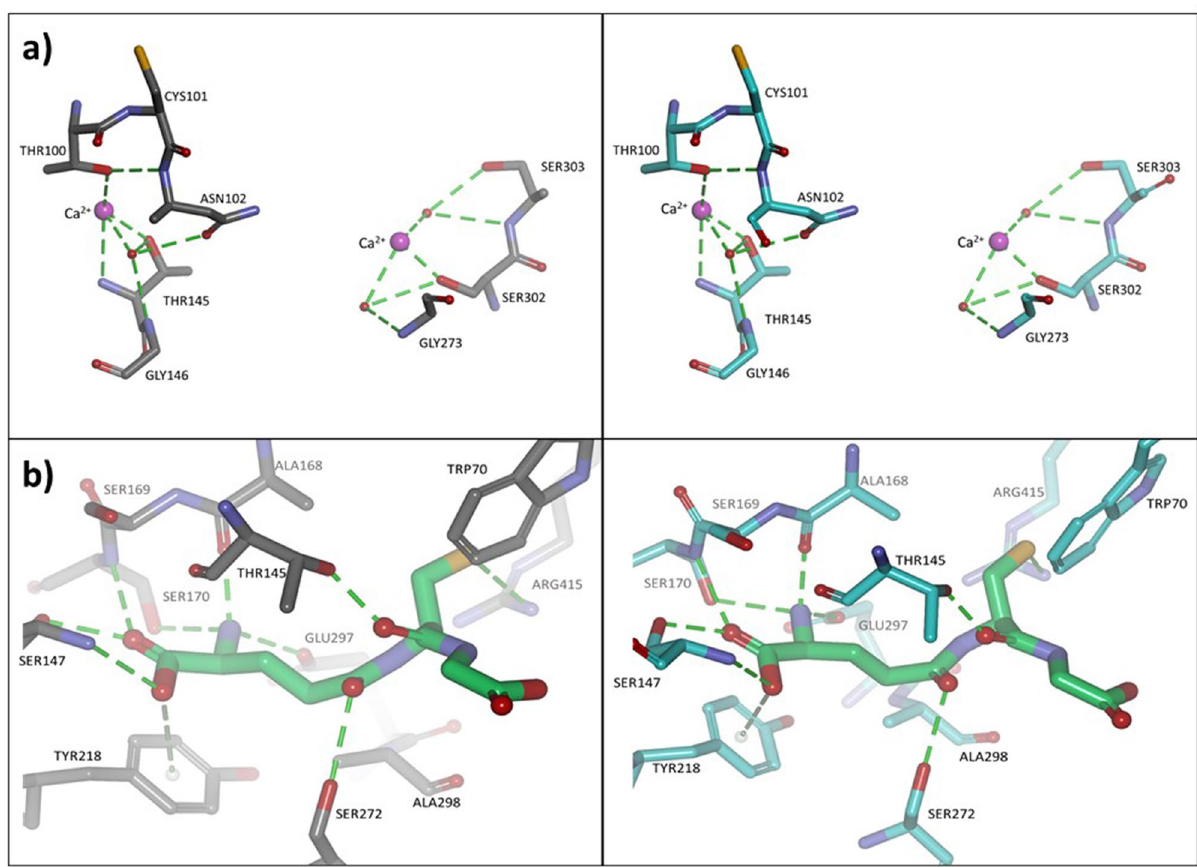
Figure 3. NTD with Ca 2+ of the hCaSR crystal structure (left) and homology model of cCaSR (right) ( a ). hCaSR (left) and cCaSR (right) with GSH bound into their respective binding sites ( b ). ( a ) The Ca 2+ binding site of hCaSR (left) and the Ca 2+ binding site of cCaSR (right). The secondary structure of the hCaSR protein is in grey. The Ca 2+ binding site of hCaSR (PDB structure 5fbk that was the template for cCaSR) is identical to cCaSR, including the enumeration of the amino-acids. The secondary structure of the cCaSR protein is in cyan. ( b ) The GSH (in green) binding site is also situated in the NTD of hCaSR (left) and cCaSR (right). The GSH binding site of hCaSR is identical to cCaSR, including the enumeration of the amino-acids. In both species, hydrogen bonds form with residues ALA168, THR145, SER147, SER170, SER272, GLU297; hydrophobic interaction with TYR218; charged interaction of zwitterionic nitrogen of the amino acid group to GLU297; charged interaction of the carboxyl group to Ca 2+ (not shown for clarity of image). The images were generated using with the Discovery Studio Visualizer (BIOVIA, Dassault